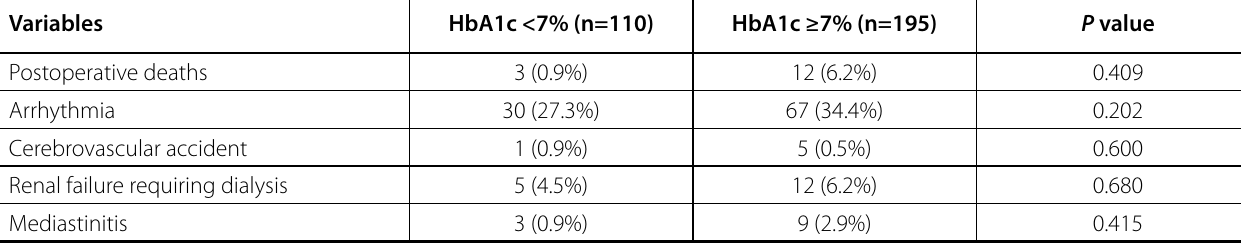
Table 3. Comparison of postoperative morbidity and mortality with preoperative HbA1c levels.